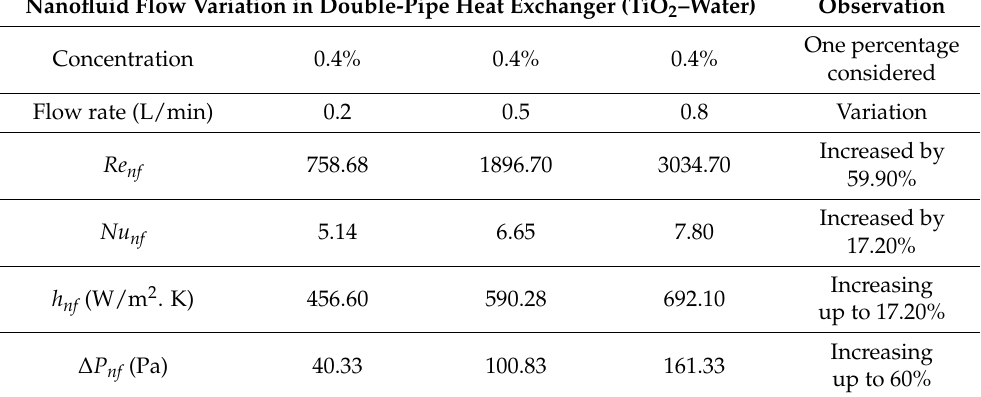
Table 7. Summary of nanofluid flow rate variation effects on flow regime, heat transfer coefficient, and pressure drop.